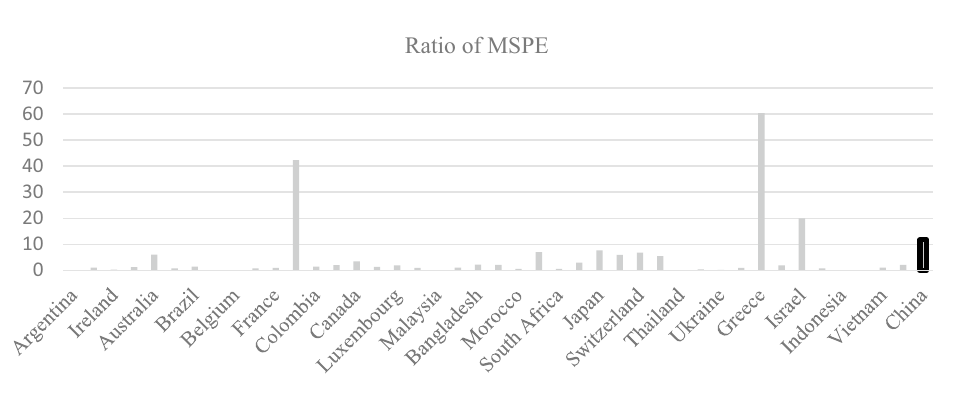
Figure 4. Permutation test of energy consumption per unit